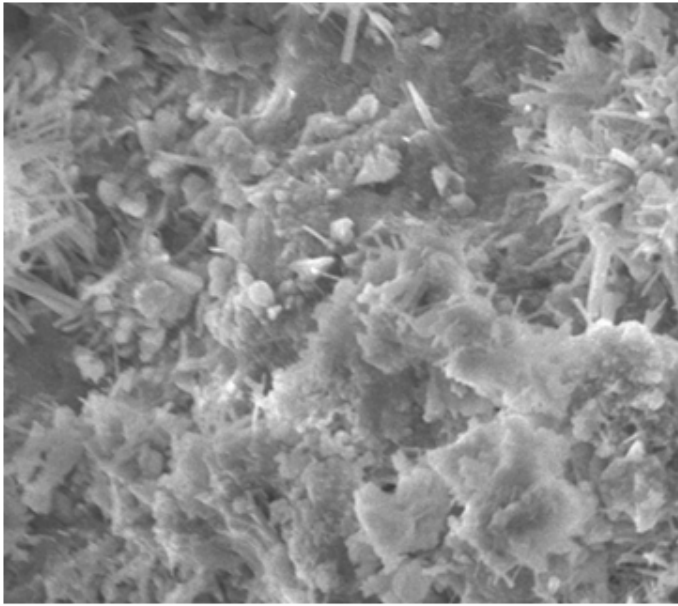
Figure 18. Foundry sand and coconut shell replacement in concrete.